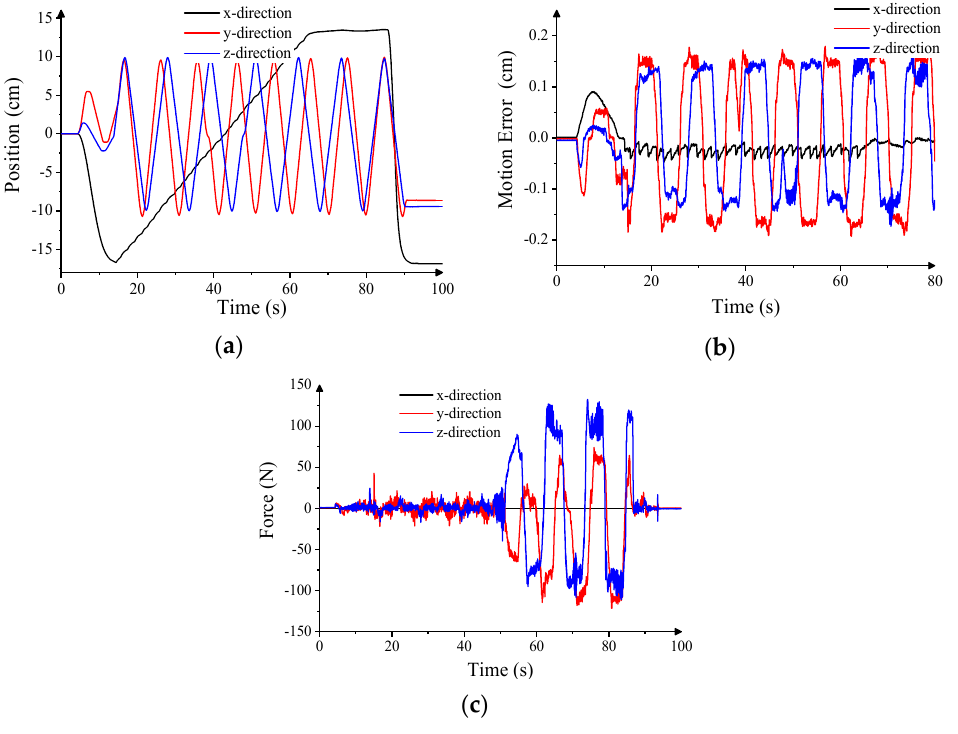
Figure 20. Dynamic inserting experiment: ( a ) position tracking, ( b ) motion error, and ( c ) interaction